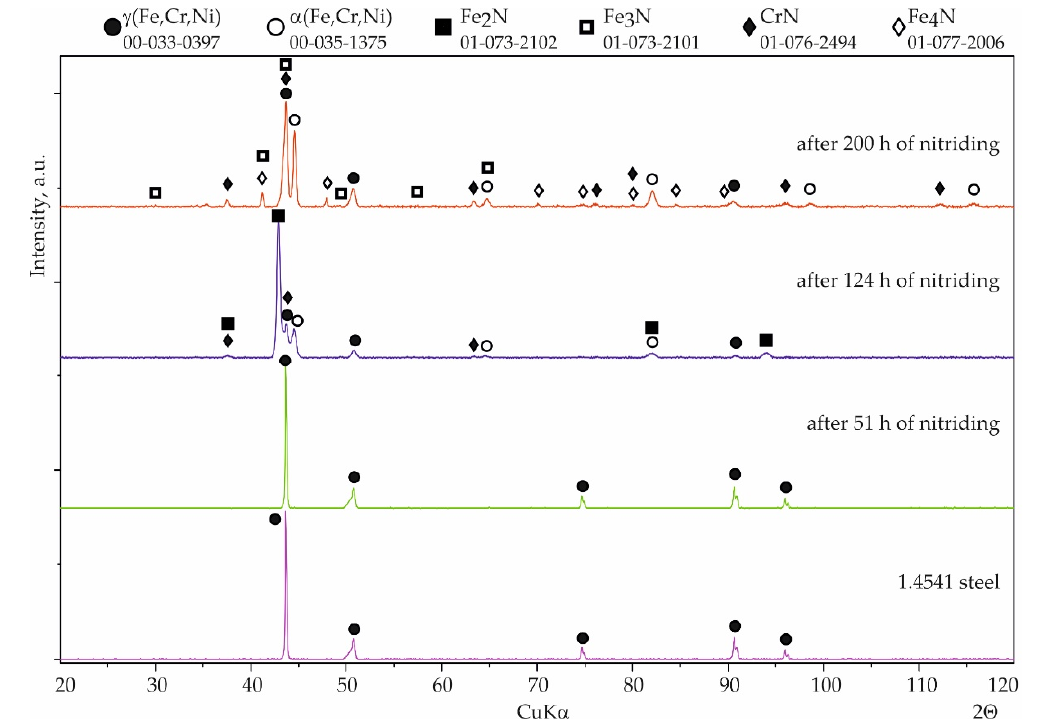
Figure 6. Qualitative X-ray structure analysis (XRD) of the 1.4541 steel; from the bottom: in the initial state; after 51 h of nitriding; after 124 h of nitriding; and after 200 h of nitriding.